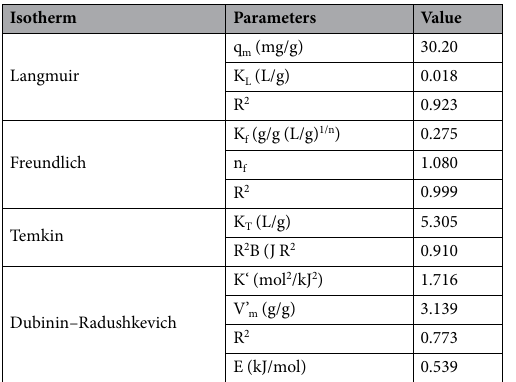
Table 1. Estimated parameters for oil adsorption process onto NMAC.